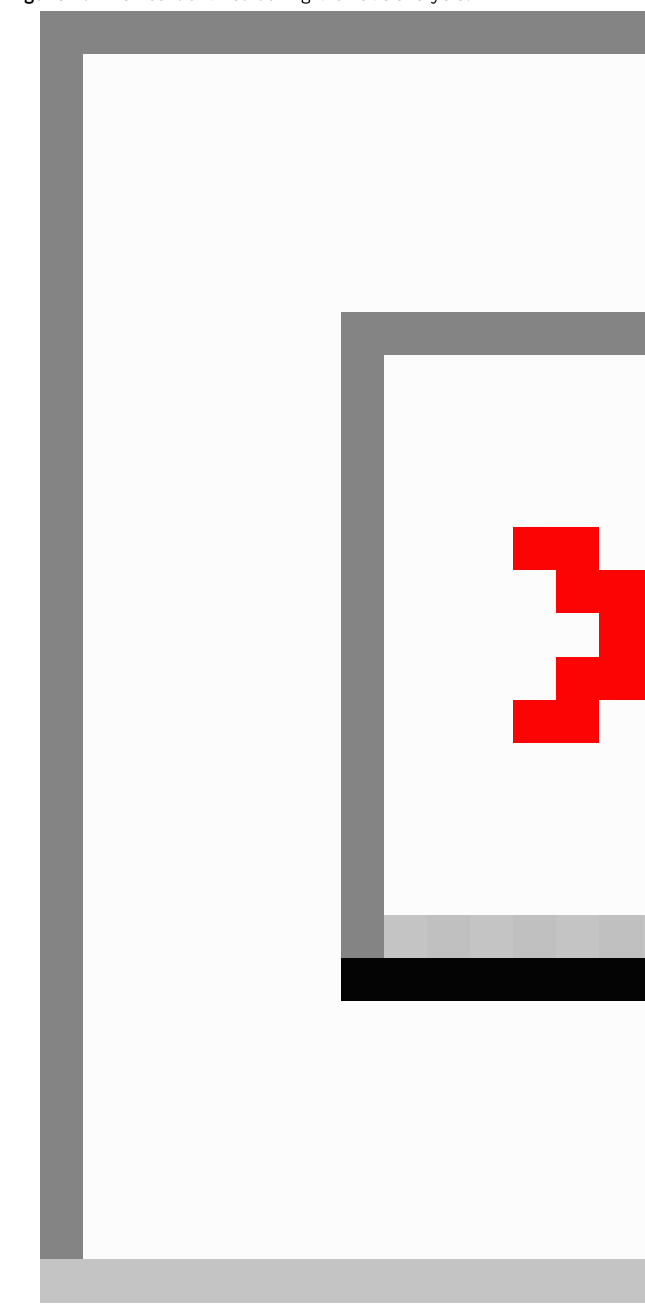
Figure 2. Themes identified during thematic